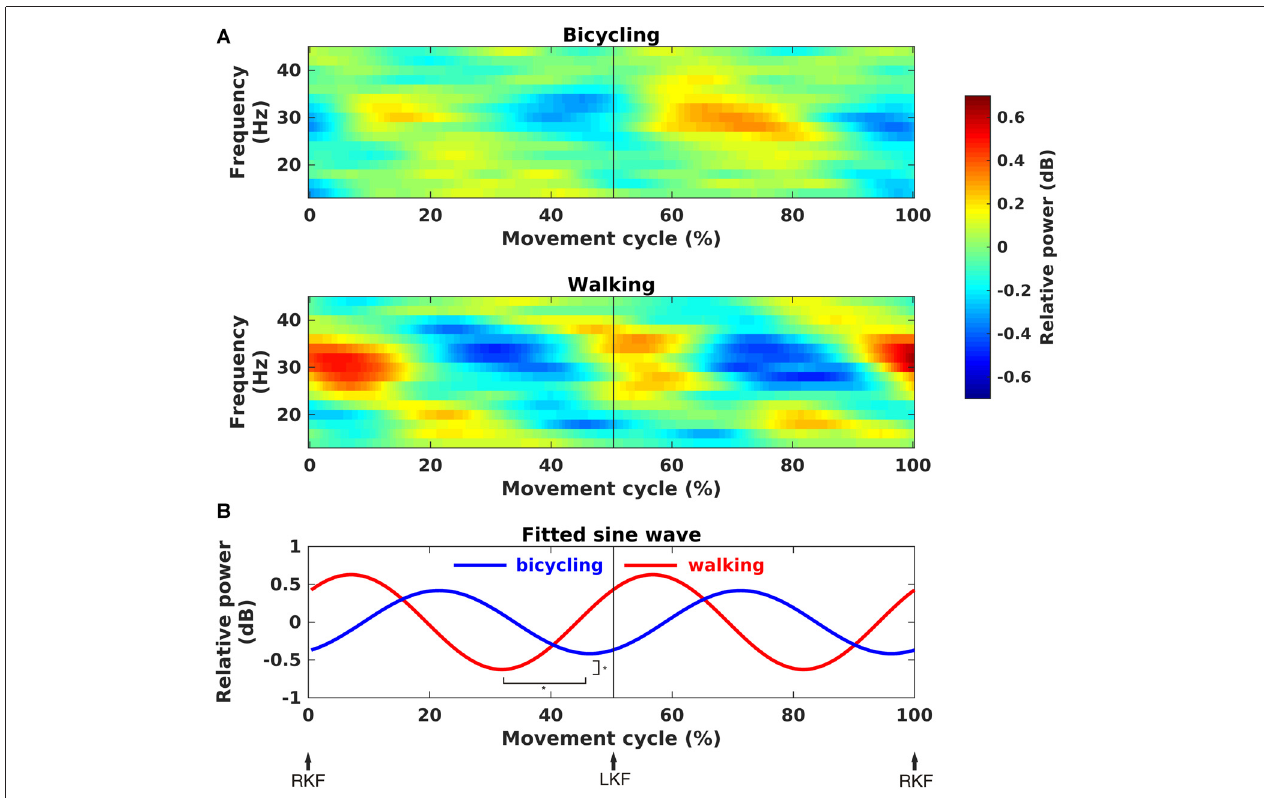
FIGURE 4 | Movement phase-dependent power modulations . (A) Grand average time-frequency representations of power changes within the movement cycle relative to the movement cycle mean power (in dB). Sinusoidal power modulations can be observed in the frequency range 24–40 Hz in bicycling (upper panel) and walking (lower panel). (B) Grand average sine wave fitted to the power modulation within the movement cycle. The fit was performed for the frequency of maximal movement phase modulation in each individual. It was based on a two-period pattern representing the power modulation with every single leg movement, i.e.,